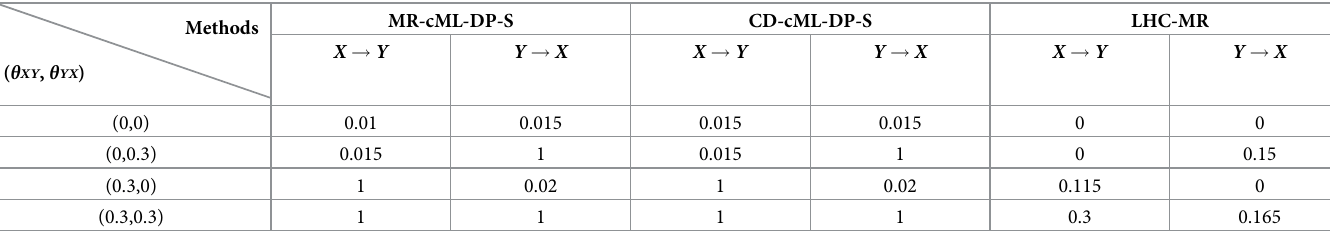
Table 1. Empirical type I error and power in the secondary simulations comparing MR-cML-DP-S, CD-cML-DP-S and LHC-MR.